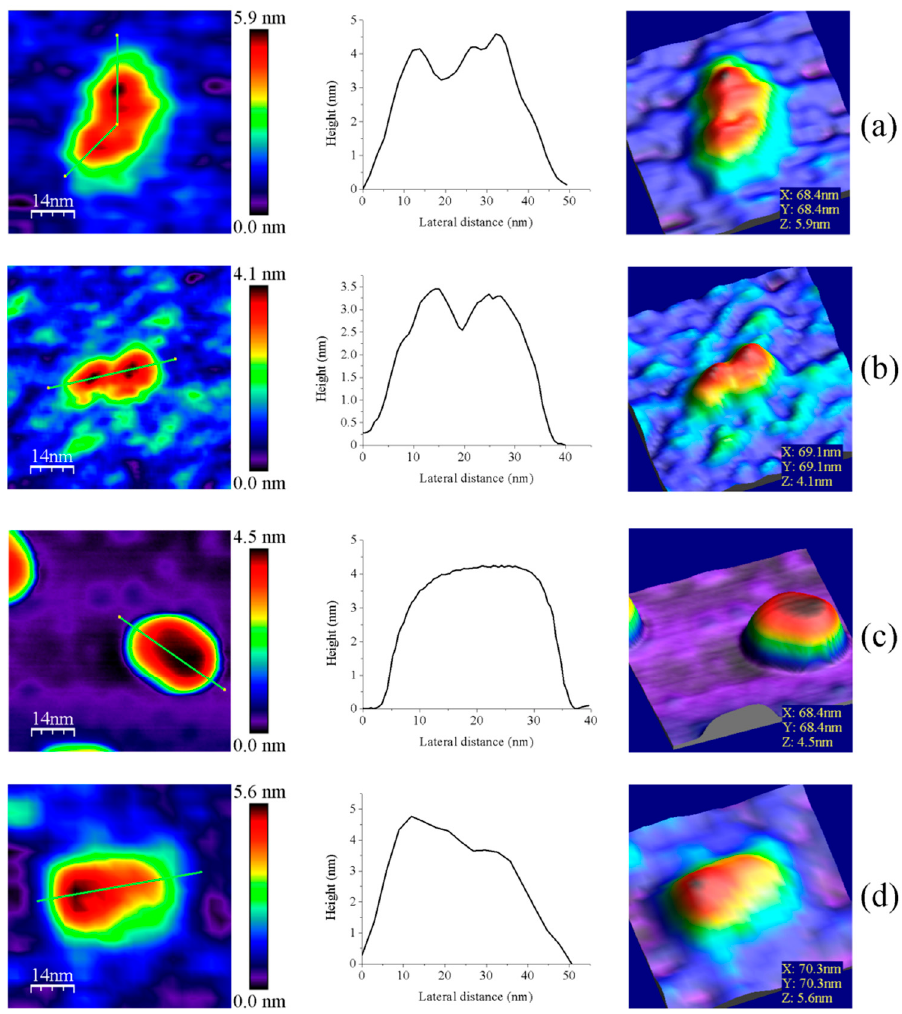
Figure 4. Representative images for homodimers of ( a ) GvFFTR; ( b ) CaFFTR2; ( c ) GvDDOR; and ( d ) GvFFTR_ ∆ tail. The topography images are shown in 2D (left panels) and 3D (right panels), and the height profiles (central panels) correspond to the green lines traced on the 2D topography images. Samples were measured in PBS pH 7.0. Scan sizes for all images are 70 nm × 70 nm.